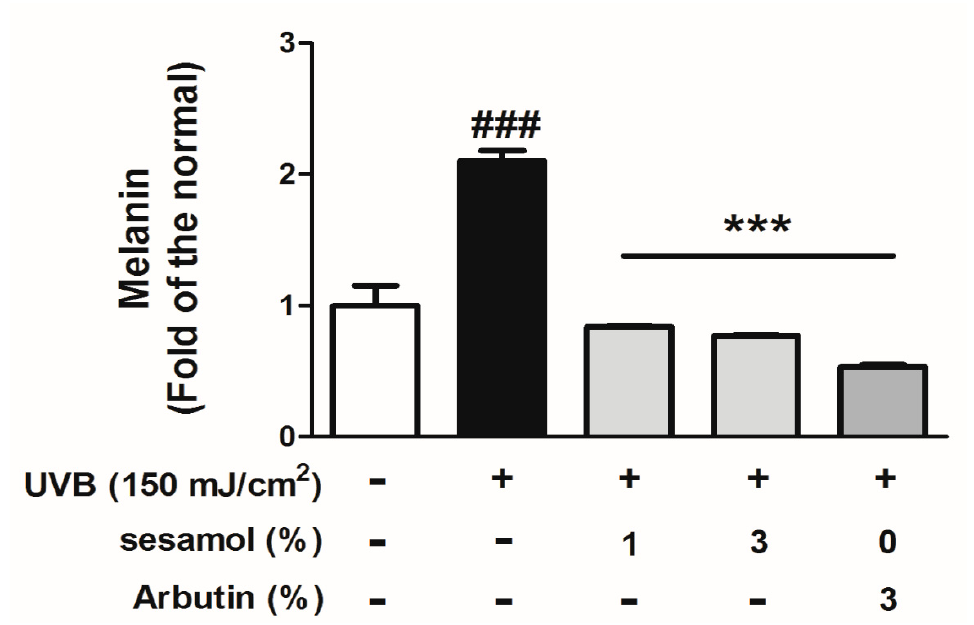
Figure 6. Effect of sesamol on UVB-irradiation-induced hyperpigmentation in C57BL/6 mice ear skin. Melanin pigments (as indicated by the arrows) were stained black by Fontana-Masson staining (400X). Topical application of sesamol reduced melanin pigments. (Significant difference versus control: ###, p < 0.001. Significant difference versus UVB treated group: ***, p < 0.001.).